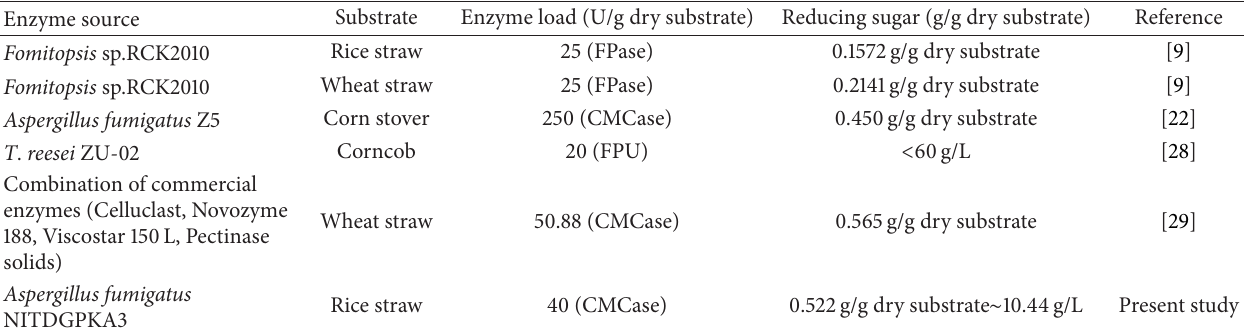
Table 4: Comparison of enzymatic hydrolysis yield of alkali pretreated rice straw by the crude enzyme of Aspergillus fumigatus NITDGPKA3 with other